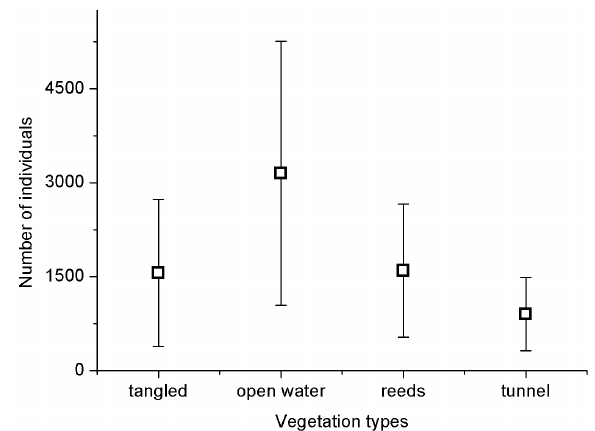
Figure 2. Number of Cladocera individuals by vegetation type.